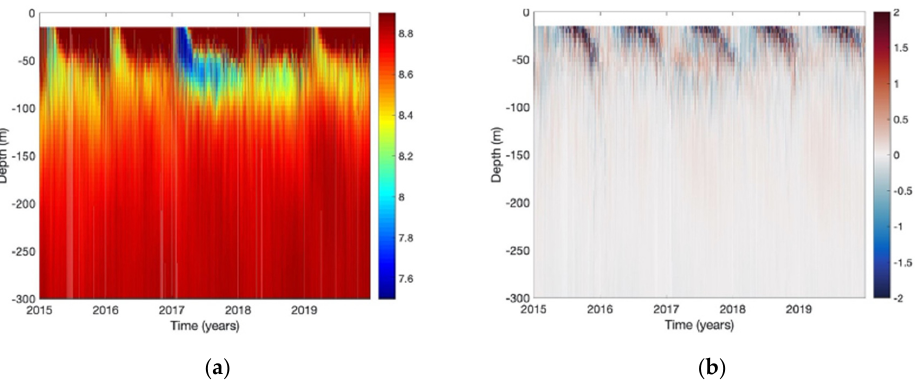
Figure 8. Time versus depth diagram for BSFS temperature in the period 2015–2019 ( a ) at the observation location and ( b ) for the computed model minus observation value.